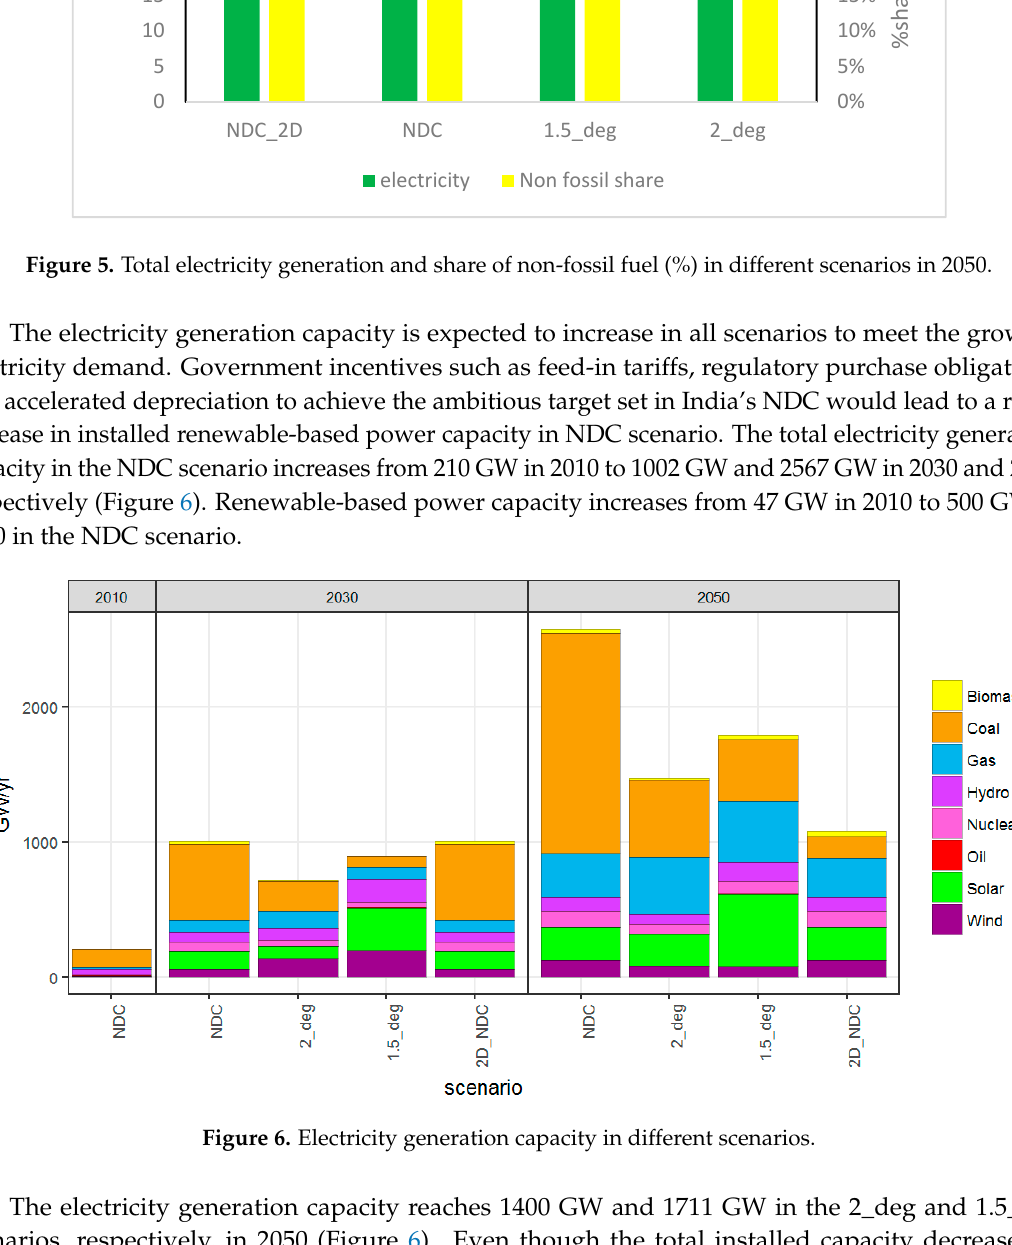
Figure 6. Electricity generation capacity in different scenarios.